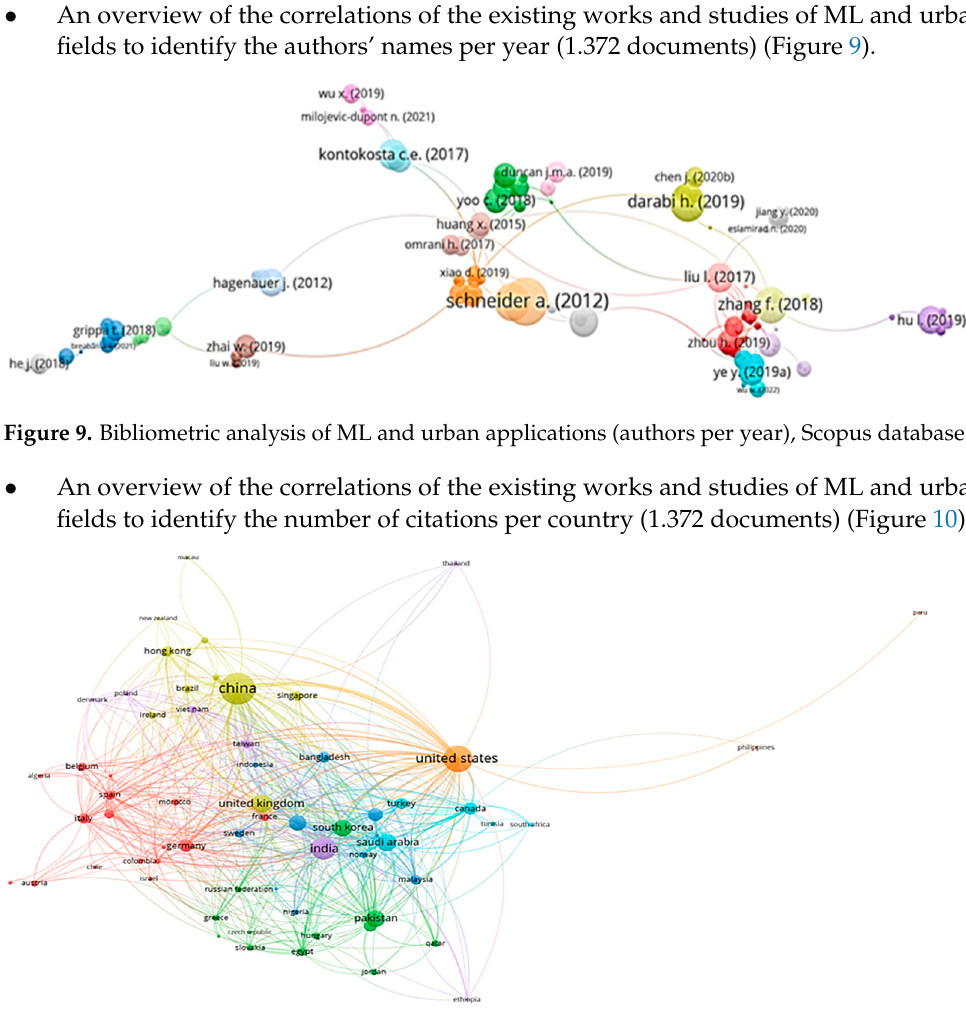
Figure 10. Bibliometric analysis of ML and urban applications (citations per country), Scopus data ‐ base.